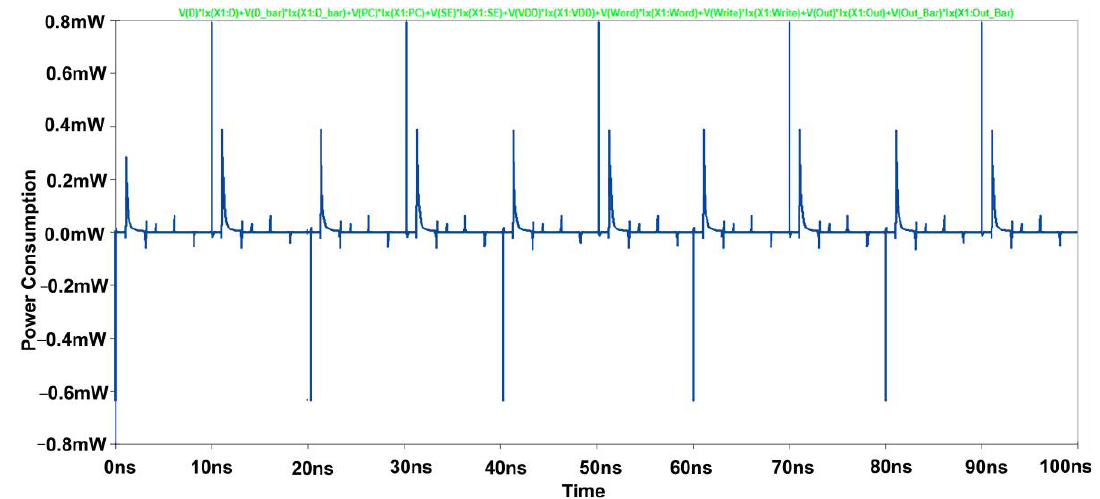
Figure 22. Power Consumption Spectrum of Proposed Sense Amplifier.